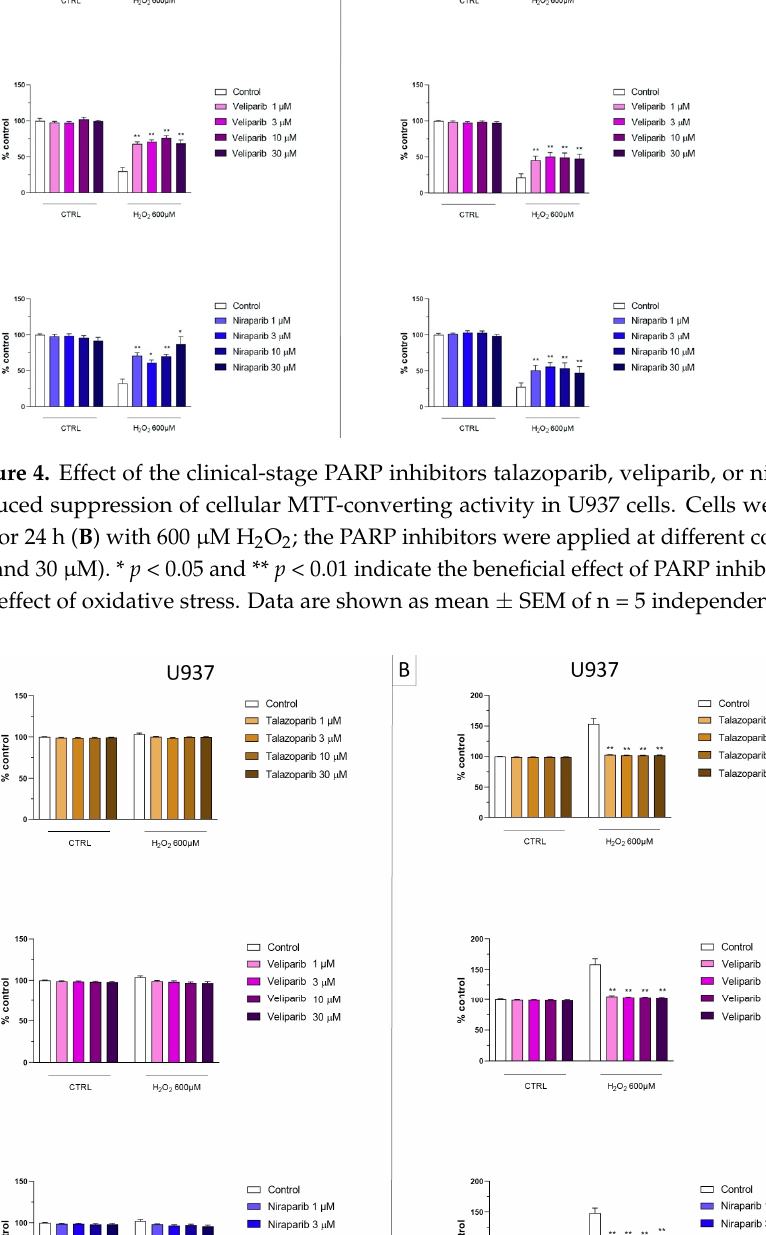
Figure 5. Effect of the clinical-stage PARP inhibitors talazoparib, veliparib, or niraparib on H 2 O 2 - induced cell necrosis in U937 cells. Cells were treated for 2 h ( A ) or 24 h ( B ) with 600 µM H 2 O 2 ; the PARP inhibitors were applied at different concentrations (1, 3, 10, and 30 µM). Cell necrosis was